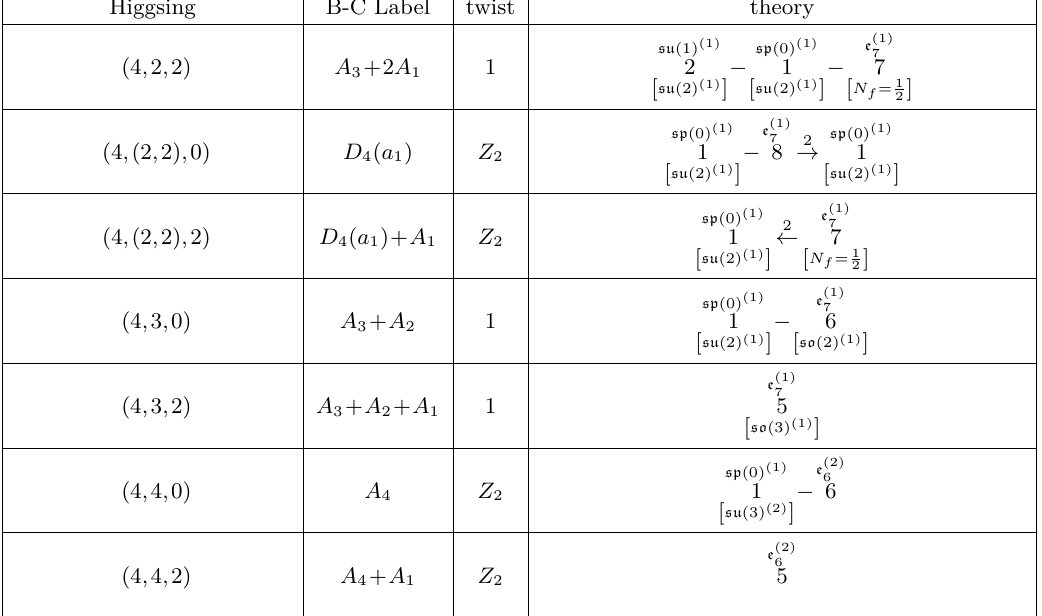
implies a half-hypermultiplet 2